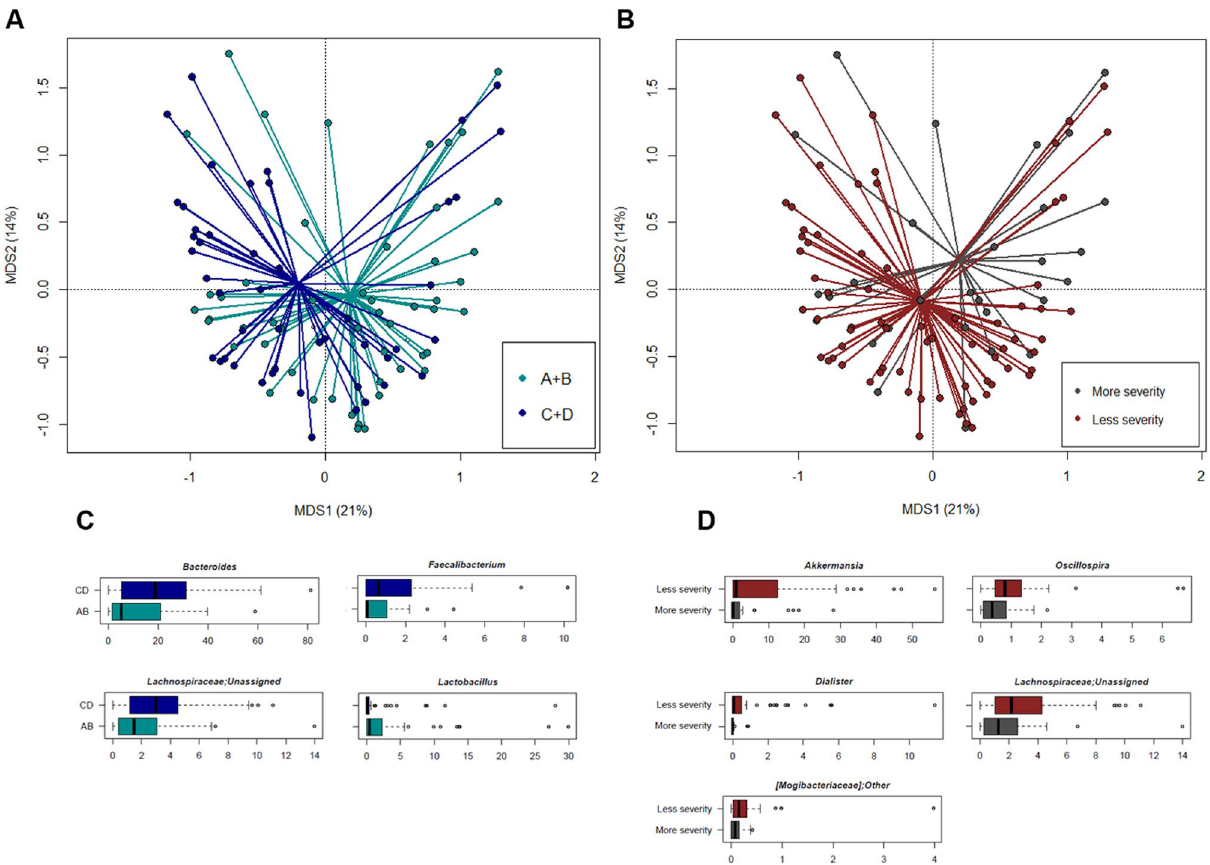
Figure 5. The gut microbiota profiles of SCI patients stratify by AIS score and severity of injury. Principal Coordinates Analysis based on Bray–Curtis distances between the genus-level microbial profiles of SCI patients according to AIS score ( A ) and SCI severity ( B ). A significant separation by both covariates was found (p ≤ 0.04, permutation test with pseudo-F ratios). More severity, AIS score A or B and neurological level of lesion between C1 to C6 and C7 to T6; less severity, AIS score A or B and lesion level between T7 and L5, and AIS score C or D and every neurological level of lesion. Box plots showing the distribution of the relative abundance values of discriminatory genera by AIS score ( C ) and SCI severity ( D ). p ≤ 0.05, Wilcoxon rank sum